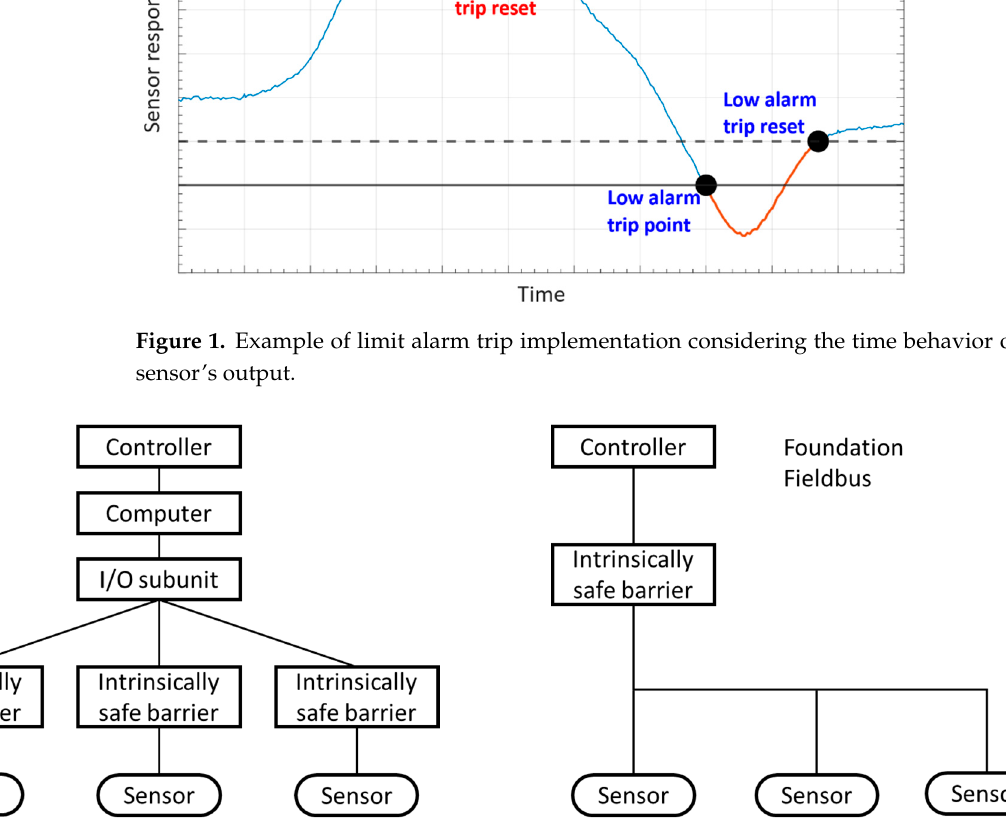
Figure 2. Schematic representation of wiring connections for sensors’ on-board diagnostics: ( a ) 4–20 mA HART ® protocol; ( b ) Foundation Fieldbus.